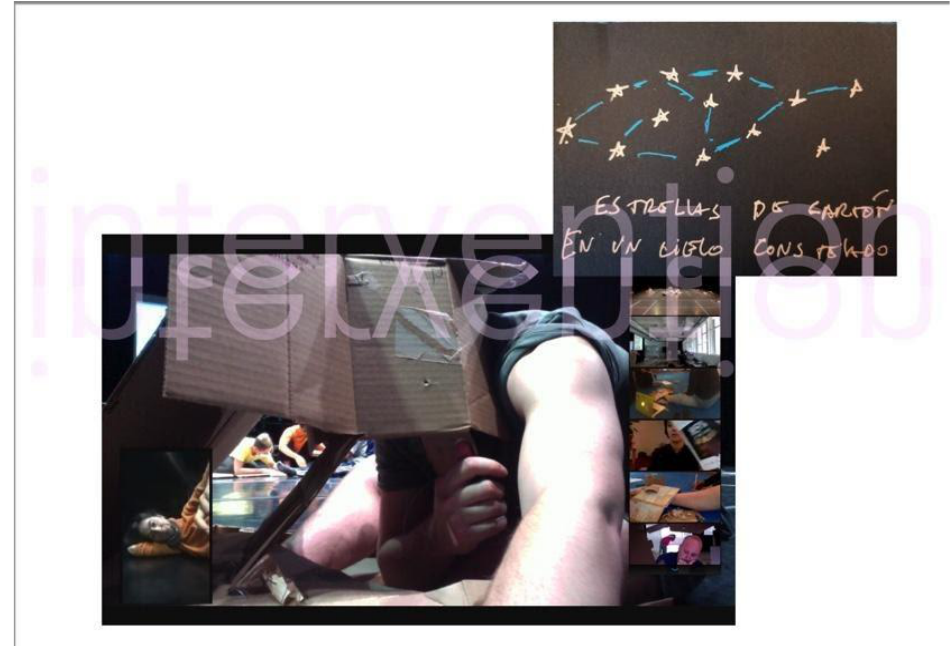
Figure 13: Page from Language is An Intangible Bridge Workshop Workbook, designed by pavleheidler and Alys Longley, with contributions by participants in the Language is An Intangible Bridge Workshop, hosted by CCOV